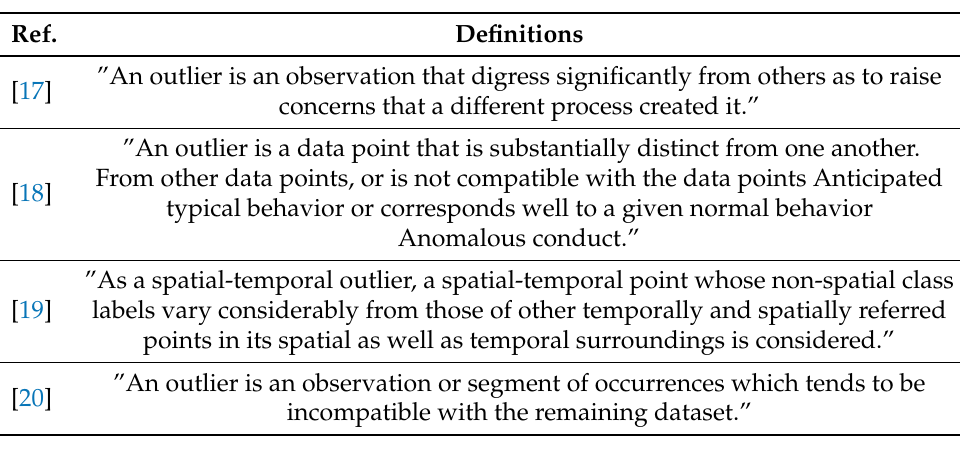
Table 2. Definitions of sensor outliers with its corresponding references